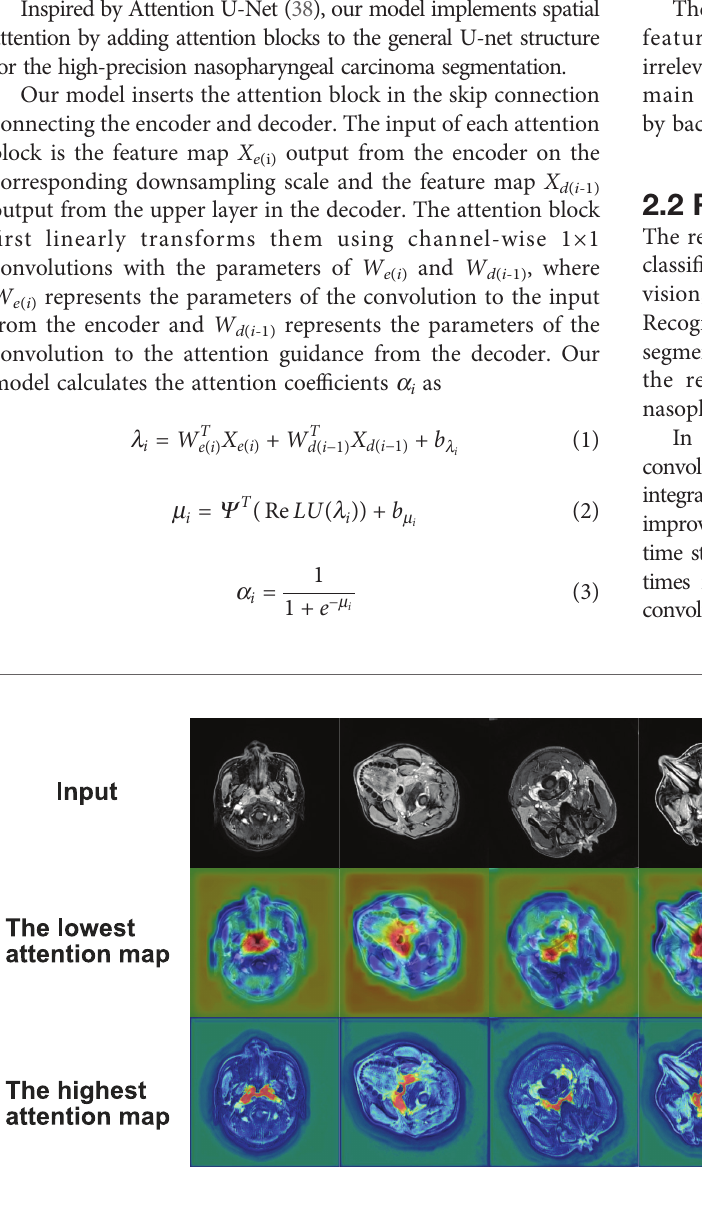
FIGURE 3 | Radar plot showing the comparison of evaluation metrics obtained from each model in the comparison experiment. The fi ve vertices of the radar plot respectively represent the average DSC value, average sensitivity, average speci fi city, average precision, and average Jaccard similarity coef fi cient. Note that this radar plot uses percentages to express the above evaluation metrics to make the comparison more distinguishable, as shown in equation